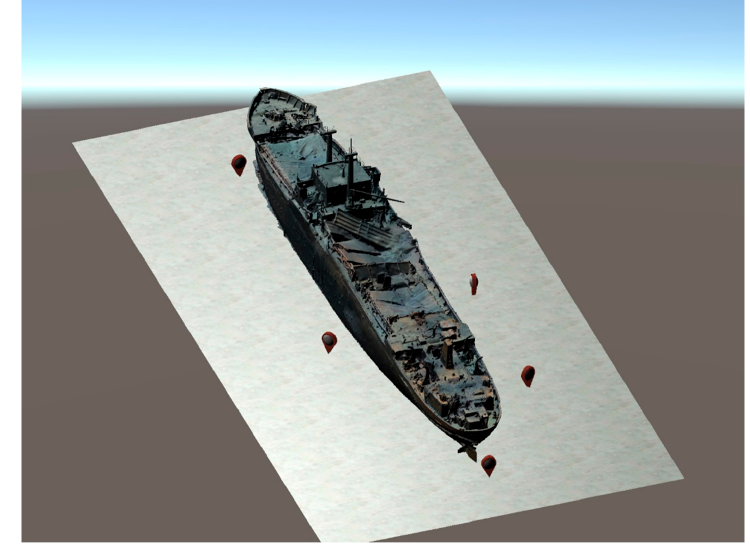
Figure 4. A modern shipwreck.